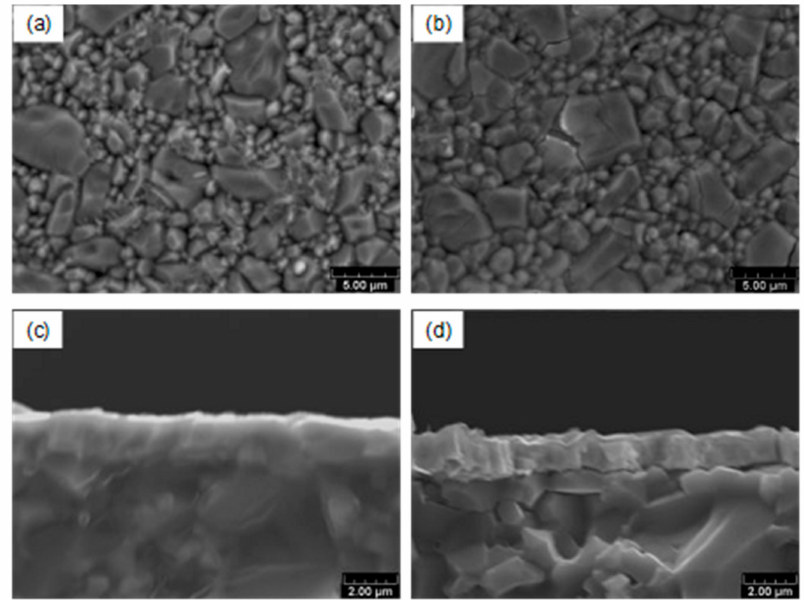
Figure 4. SEM images of the surface and the brittle cross section of the LaCoO 3 sample synthesized with I Co = 0.3 A and I La = 1 A: ( a , c ) as deposited coating and ( b , d ) after calcination treatment at 500 ◦ C for 2 h under air.